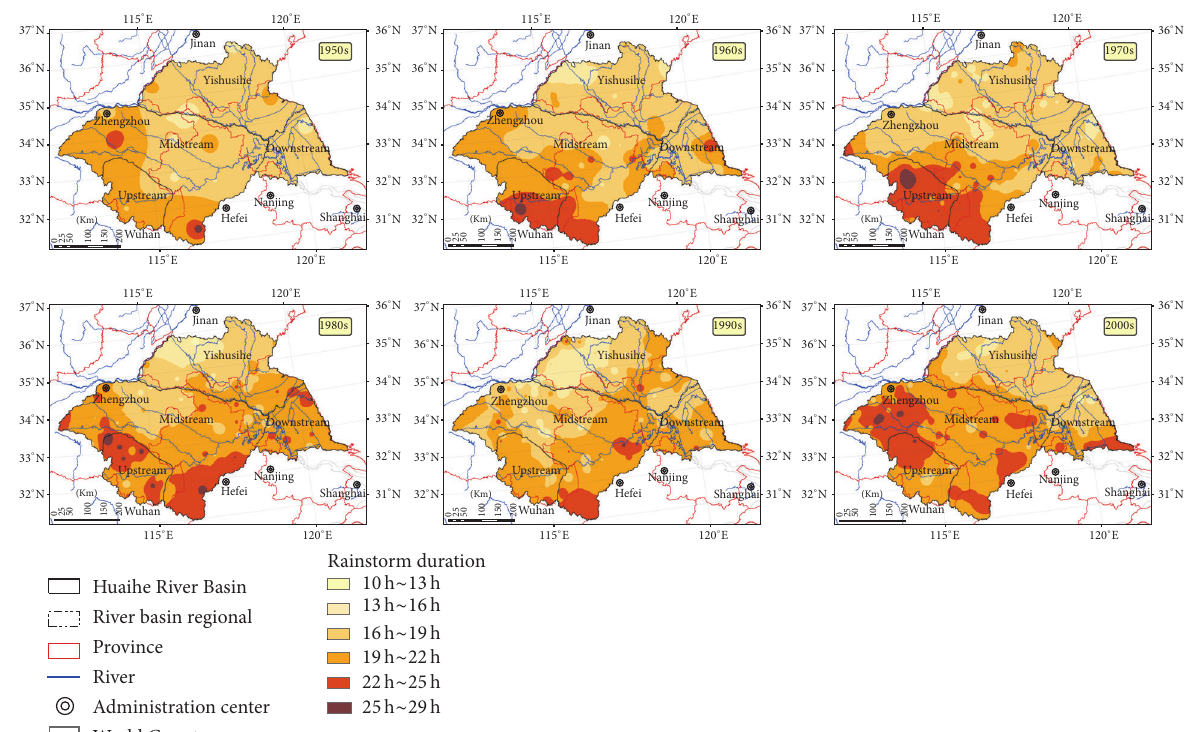
Figure 8: Spatial distribution of isolated rainstorm event duration during